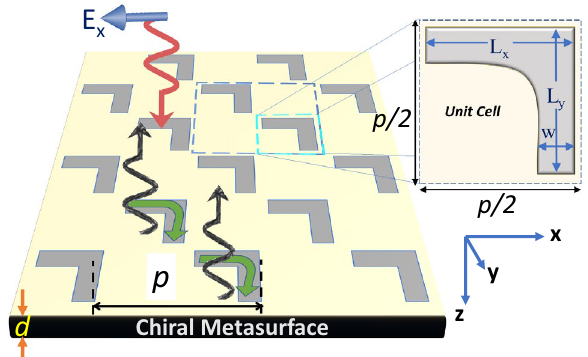
Figure 2. Schematic illustration of plasmonic single-L chiral reflecting metasurface on dielectric substrate of thickness d = 642 nm . Inset shows L-shaped silver nanostructure of thickness 100 nm. Here p = 2 μm, L x = L y =700 nm and w = 200 nm. Illustrations were created in Microsoft Powerpoint 365 [https:// www. micro soft. com/ en- ww/ micro soft- 365/ power